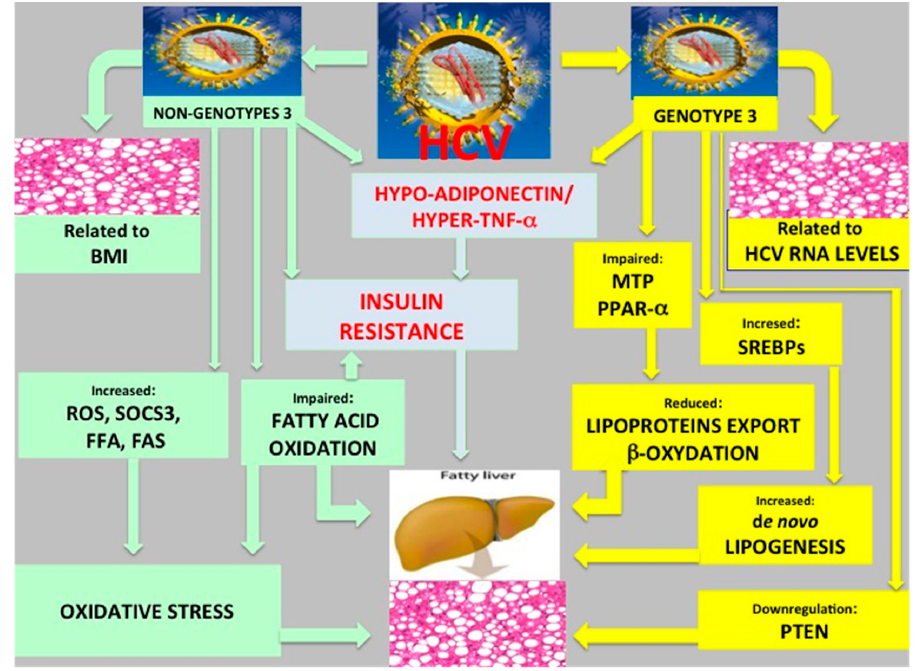
Figure 1. Schematically are illustrated the mains HCV genotype-specific molecular mechanisms of steatogenesis. Abbreviations used: HCV: hepatitis C virus; BMI: body mass index; MTP: microsomal triglyceride transfer protein; PPAR- α : peroxisome proliferator-activated receptor α ; SREBPs: sterol regulatory element-binding proteins; ROS: reactive oxygen species; SOCS3: suppressor of cytokine signaling 3; FFA: free fatty acid; FAS: fatty acid synthase; PTEN: phosphatase and tensin homolog.